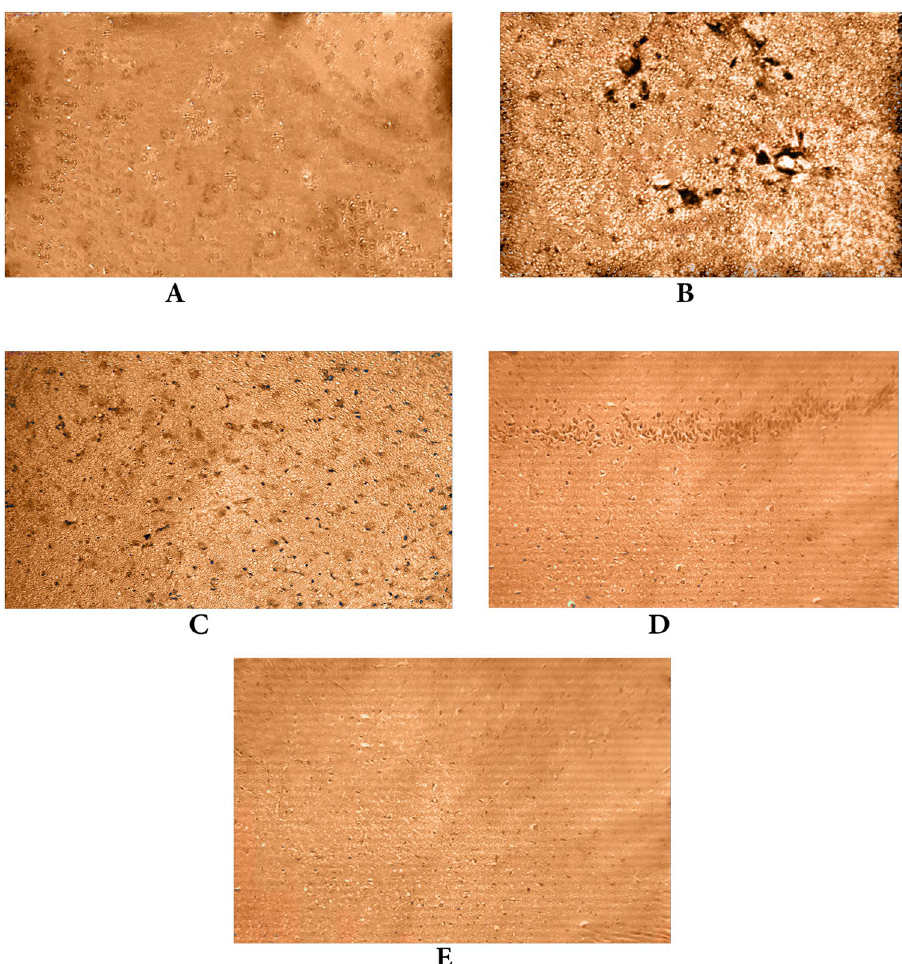
7 days. ( C ) The celecoxib group received STZ (3 mg/kg, i.c.v.) once, and after 2 weeks, they were injected with celecoxib (30 mg/kg, i.p.) for 7 days. ( D ) The gingerol (10 mg/kg) group received STZ (3 mg/kg, i.c.v.) once, and after 2 weeks, they were injected with gingerol (10 mg/kg/day, i.p.) for 7 days. ( E ) The gingerol (20 mg/kg) group received STZ (3 mg/kg, i.c.v.) once, and after 2 weeks, they were injected with gingerol (20 mg/kg/day, i.p.) for 7 days. Scale bar, 60 µ m ( A–E